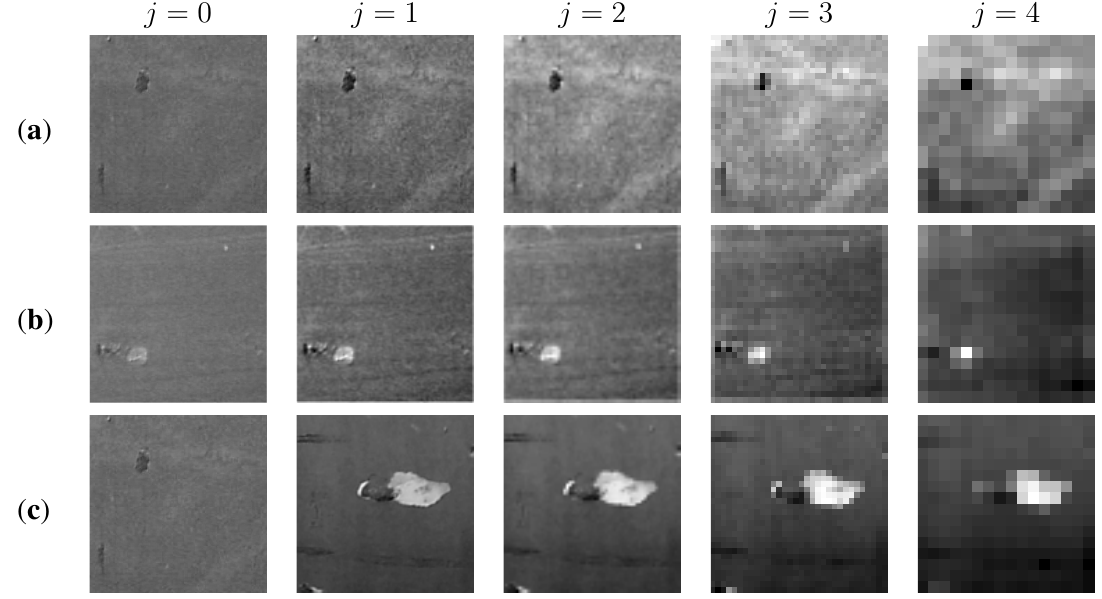
( x; y ) ) of four wavelet decomposition levels LL